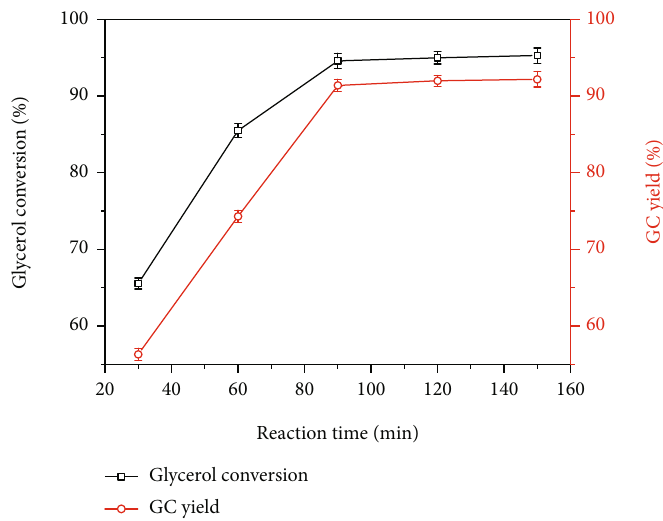
Figure 7: E ff ect of reaction time on glycerol conversion and GC yield.